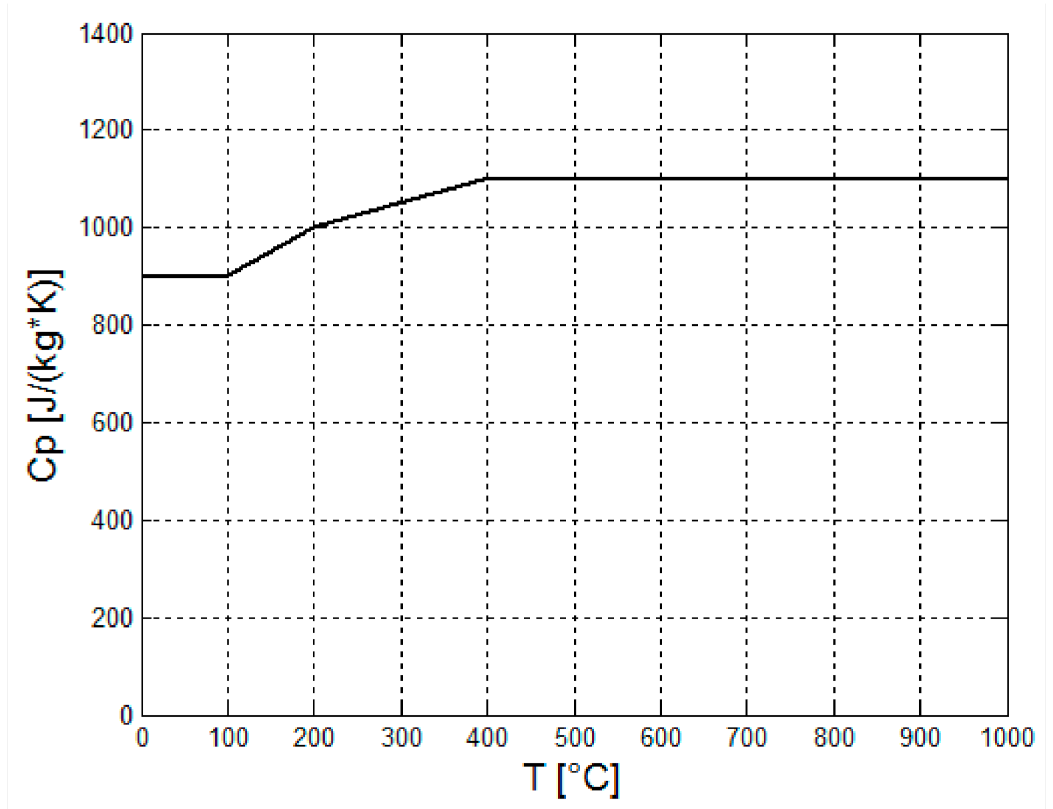
Figure 5. Temperature-dependent heat capacity of the concrete [19].